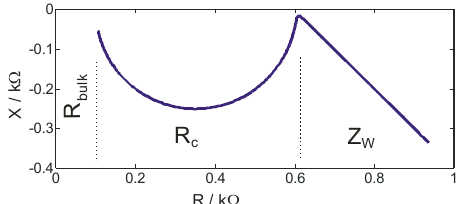
Fig.2: Impedance of a hypothetical metal electrode ( A = 1 mm 2 ) in contact with 1 mM KCl ( R bulk = 100 (cid:58) , R c = 500 (cid:58) , C dl = 30 mF/cm 2 , D = 5 . 10 -8 m 2 /s, T = 296.15 K) in a frequency range from 100 Hz < f < 100 MHz with undisturbed diffusion layer